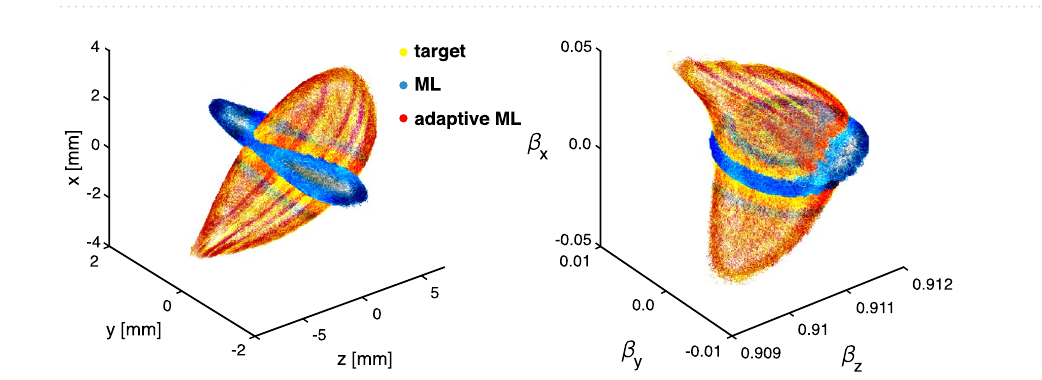
Figure 8. ( A ) The output beam distribution prediction adaptively tracked by tuning solenoid current and PCA components. ( B ) Input beam distribution is predicted with high accuracy.